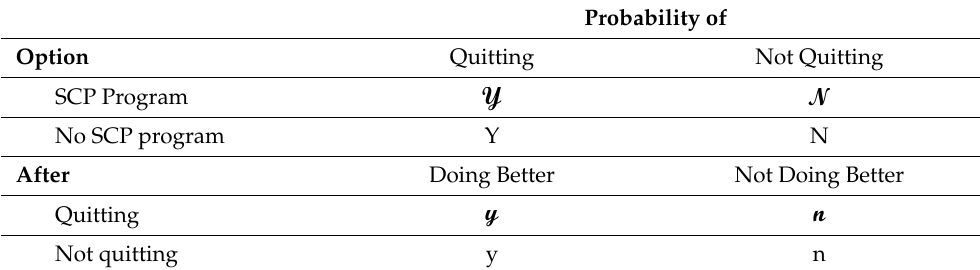
Table 1. Notation for quitting probabilities as well as doing better probabilities by program *. Probability of